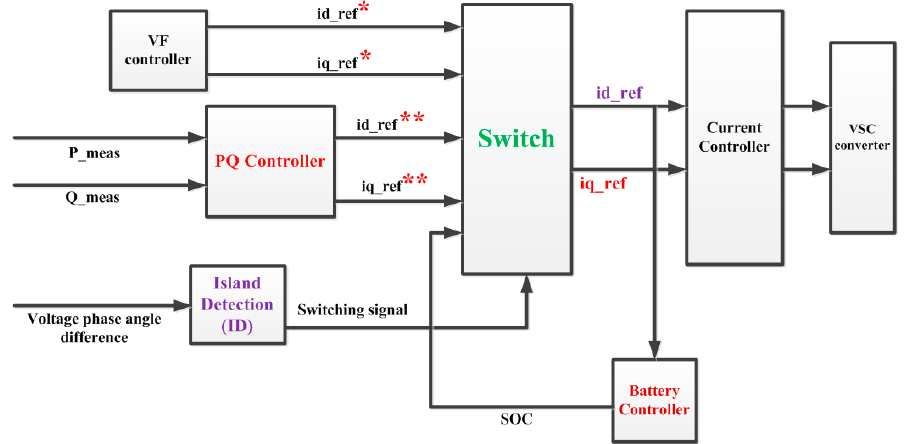
Figure 4. The switching of control system from PQ to VF mode .